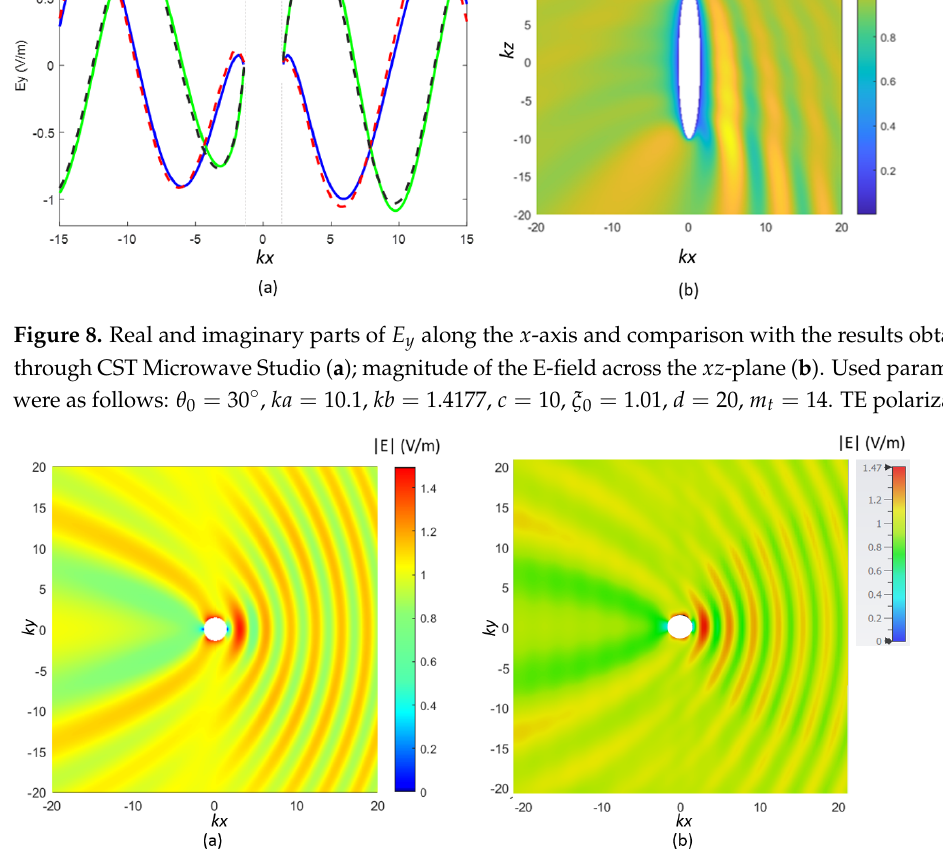
Figure 9. Magnitude of the E-field across the xy -plane: ( a ) spheroidal geometry with the same geometrical parameters considered in Figure 8 (analytical approach); ( b ) cylindrical geometry (2-D) (CST Microwave Studio). Cylinder radius was kr = 1.4177. TE